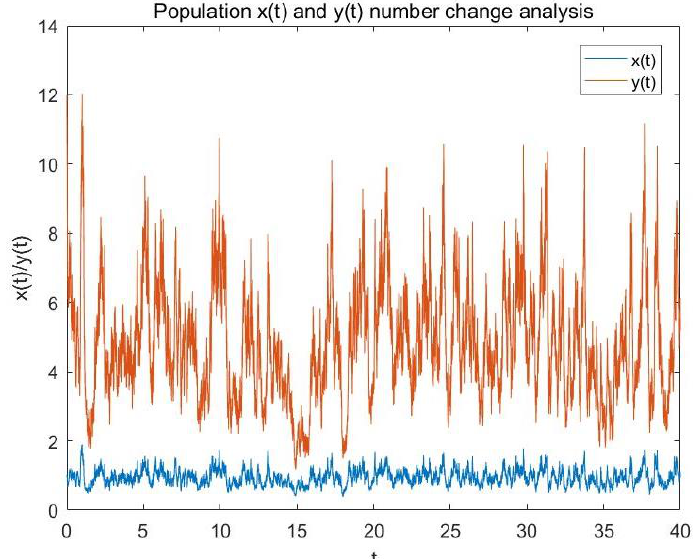
Figure 1. Stationary distribution of the model